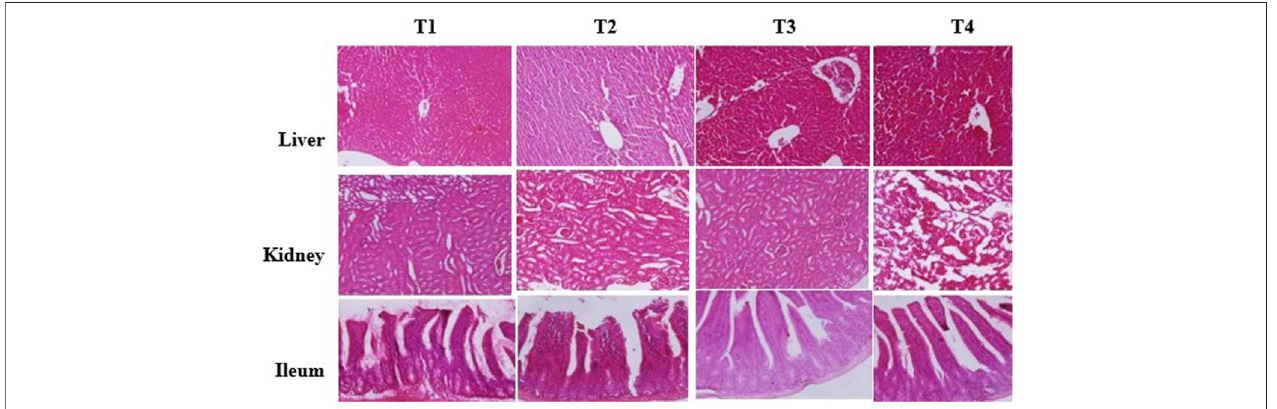
FIGURE 3 | Histopathological analysis of liver, kidney, and ileum of the mice treated with different treatment. T1: normal diet; T2: normal diet + infected by C. jejuni on day 21; T3: Normal diet enriched by PRF (10 mg TPC/kg BW/day) + infected by C. jejuni on day 21; T4: Normal diet enriched by nanoliposome-encapsulated PRF (10 mg TPC/kg BW/day) + infected by C. jejuni on day 21.